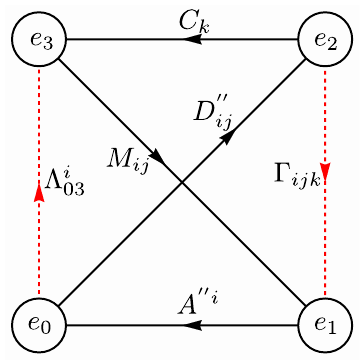
Figure 4 . Another C 4 = Z 4 (1 ; 1 ; 1 ; 1) supersymmetric quiver, which we dub \Theory